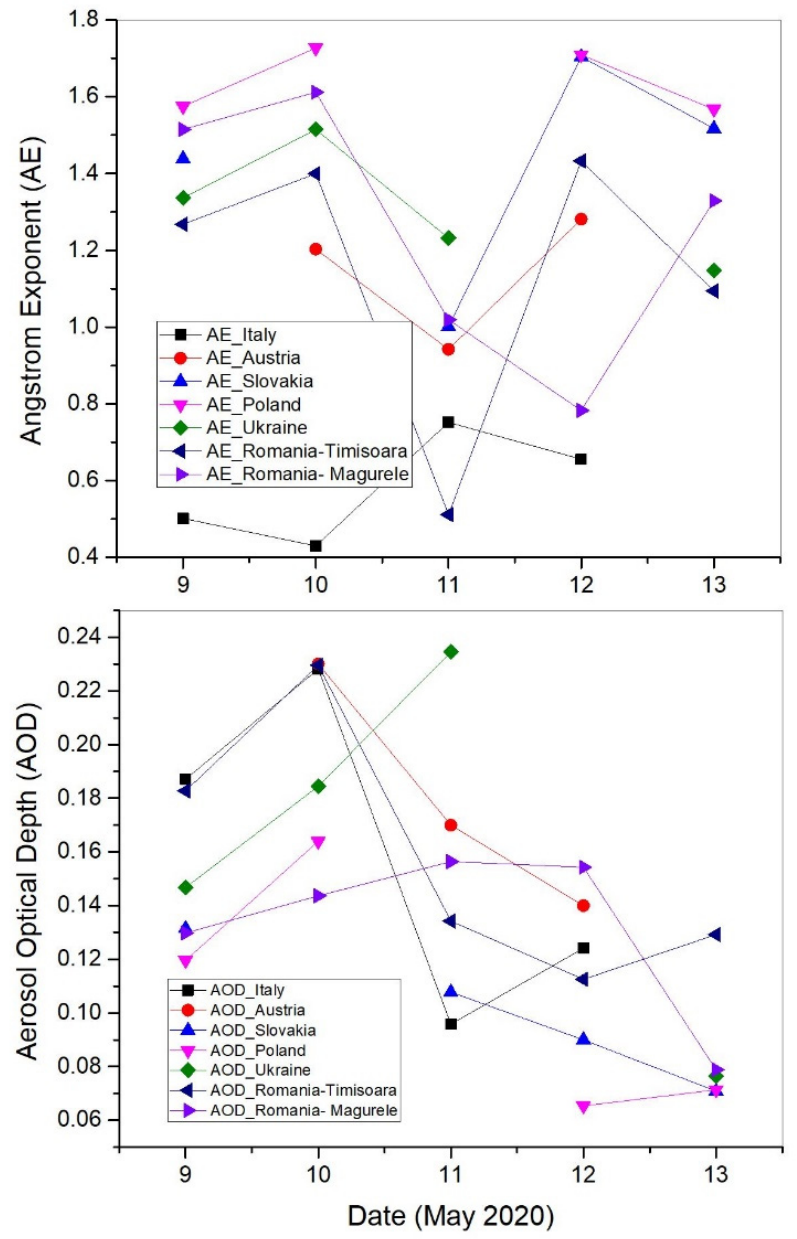
Figure 5. AOD and Angstrom exponent values at 440–870 nm, 9–13 May 2020, at Rome–La Sapienza (level 2.0), Austria-Vienna-Univie (level 1.5), Slovakia-Poprad-Ganovce (level 2.0), Poland-Strzyzow (level 1.5), Ukraine-Kiev (level 1.5), Romania-Timisoara (level 2.0), and Romania-Magurele (level 2.0).